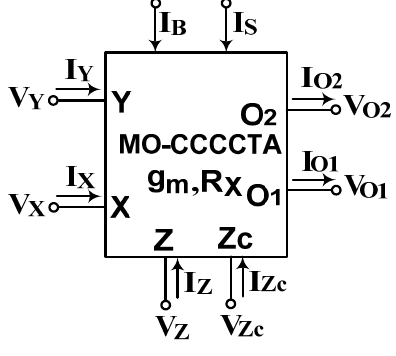
Figure 2. MO-CCCCTA symbol.